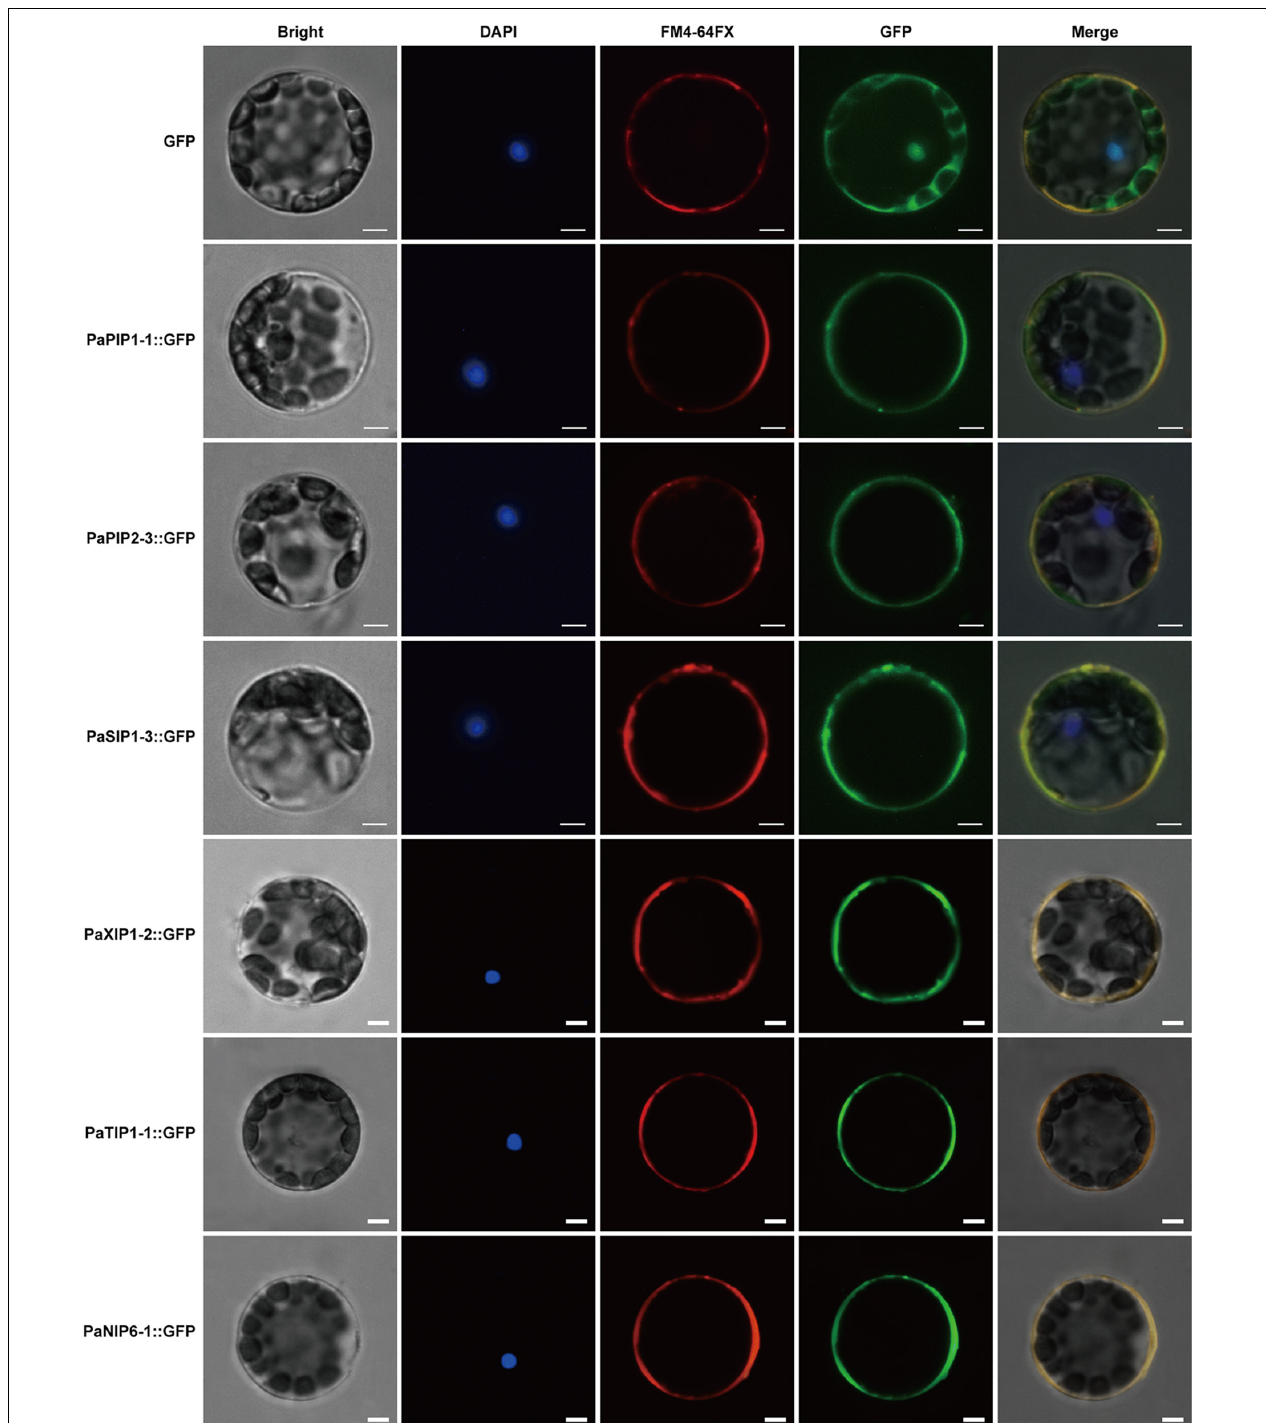
FIGURE 7 | Localization of PaPIP1-1, PaPIP2-3, PaSIP1-3, PaXIP1-2, PaNIP6-1, and PaTIP1-1 in the cell plasma membrane. Bright, Bright-field images. DAPI, nuclei counterstained with 4 (cid:48) ,6-diamidino-2-phenylindole (DAPI), a nuclear marker; FM4-64FX, FM4-64FX dye images, a plasma membrane-specific vital dye. Merge, overlap of GFP (green) and FM4-64FX (red) fluorescence. Row 1 shows the protoplasts expressing GFP alone, which was used as a control. Row 2 shows protoplasts expressing the PaPIP1-1 : GFP fusion protein with FM4-64 fluorescence. Row 3 shows the protoplasts expressing the PaPIP2-3 : GFP fusion protein with FM4-64 dye. Row 4 shows protoplasts expressing the PaSIP1-3 : GFP fusion protein with FM4-64 fluorescence. Row 5 shows the protoplasts expressing the PaXIP1-2 : GFP fusion protein with FM4-64 dye. Row 6 shows the protoplasts expressing the PaNIP6-1 : GFP fusion protein with FM4-64 dye. Row 7 shows protoplasts expressing the PaTIP1-1 : GFP fusion protein with FM4-64 dye. FM4-64FX shows a plasma membrane-specific dye. Bars = 5 µ m.